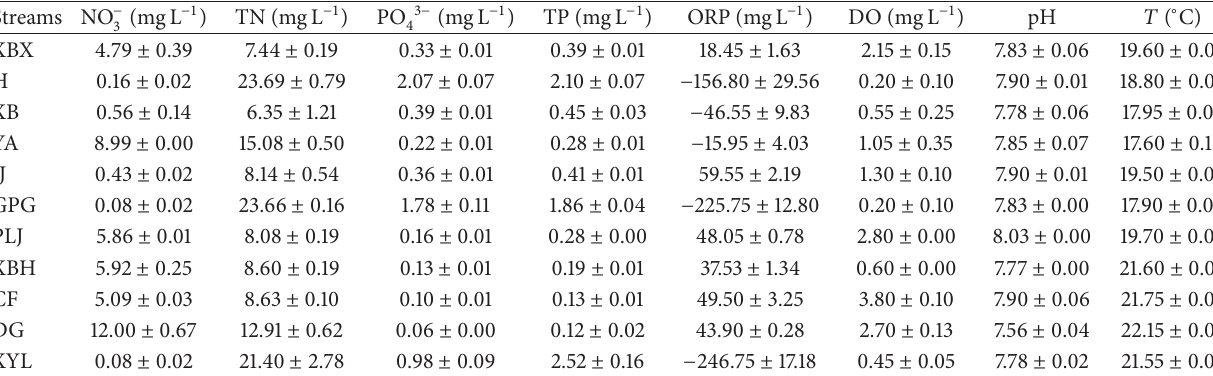
Table 1: Water properties of the streams at Dianchi Lake (mean ±